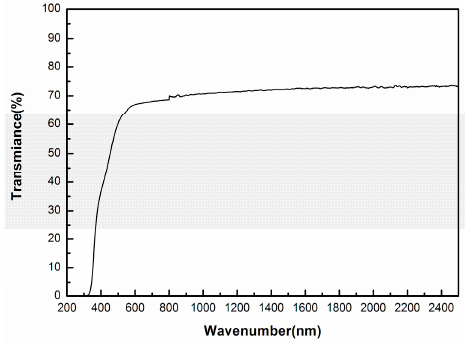
Figure 4. Transmittance spectrum of the Mg: 7 LiNbO 3 crystal.